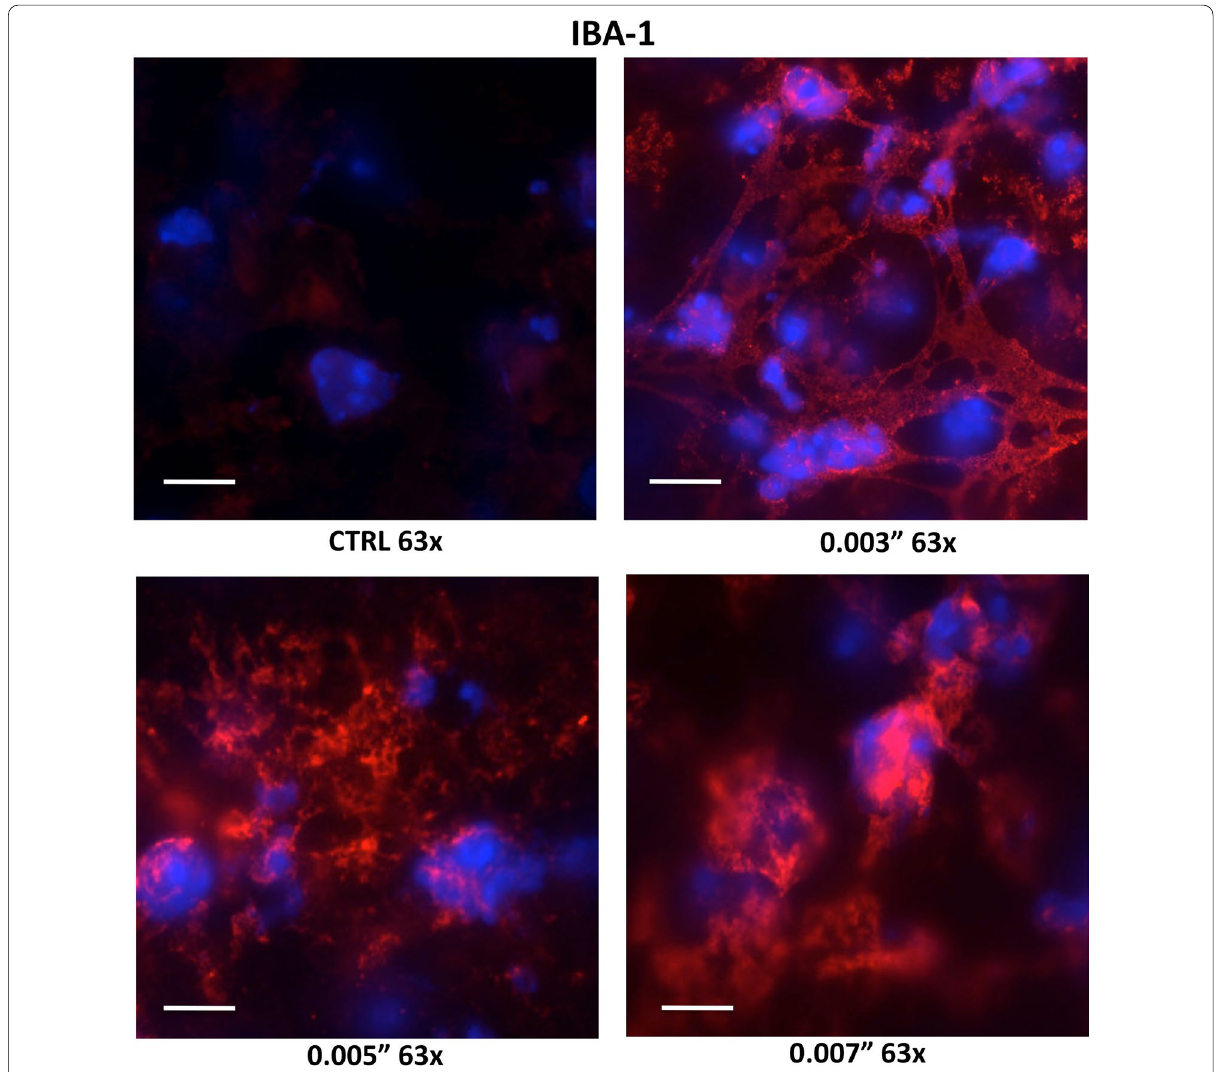
Fig. 5 TBI severity is associated with degree of microglia activation. Microglia activation is also increased in graded fashion with increased severity of injury at 72 h, as measured by